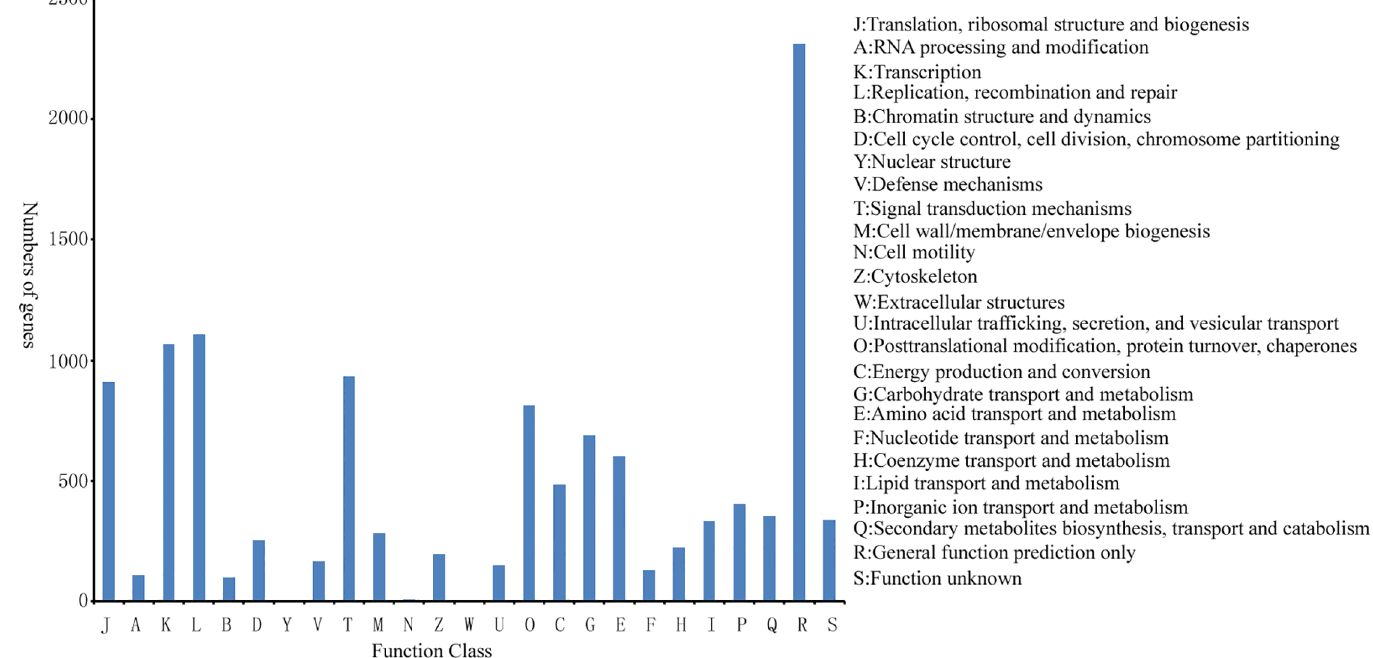
Fig 4. Functional classification of licorice based on